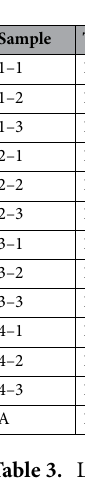
Table 3. Liquidus and solidus temperatures as measured by DSC on sample slices (1–1 to 4–3) and a bulk Cu 87 Ga 2 Sn 11 sample